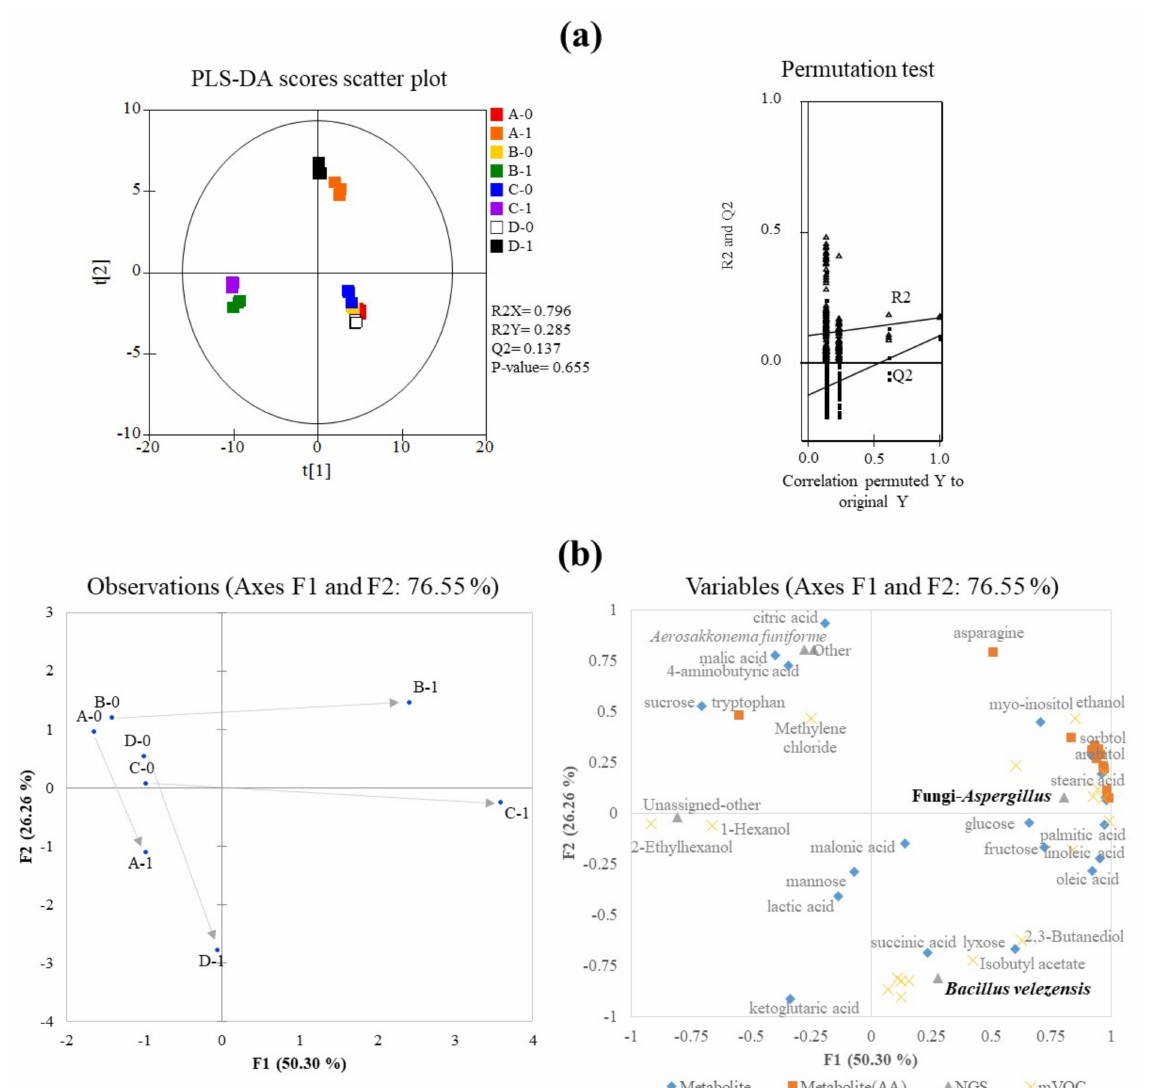
Figure 3. PLS-DA ( a ) was performed using GC-TOF-MS data and multi-factor analysis, ( b ) score plot from the set of GC-MS and NGS data from Meju samples reveal metabolic changes during fermentation among samples using different starters. Here, the datasets for raw substrates are indicated: (cid:117) , metabolites dataset except for amino acids; (cid:4) , metabolites including only amino acids; (cid:53) , microbial volatile datasets; (cid:78) , metagenome datasets based on 16S rRNA and ITS